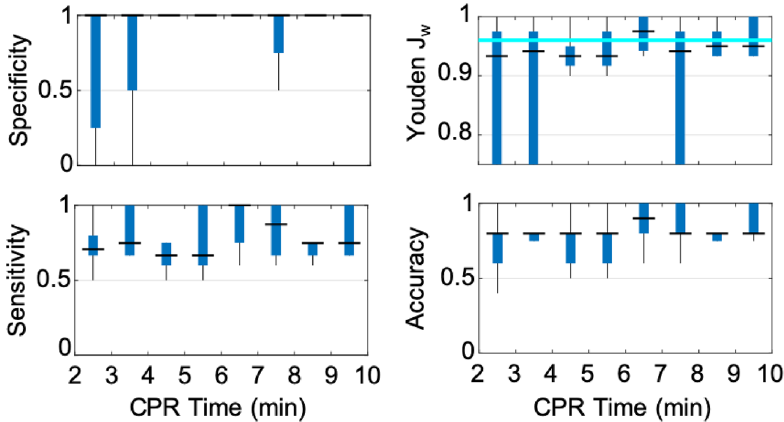
Figure 5. Time-Dependent Prediction Performance during Early CPR: The predictive performance of the optimal decision threshold (Δ[HbO 2 ] CPR ≥ + 1.3 µmol/L), across 10 independent test folds, is summarized (median, horizontal line ; interquartile range, box ; range, whisker ) minute-to-minute from 2 to 10 min of CPR. Within each 1-min interval, the decision threshold was applied to predict ROSC in each test fold and the corresponding specificity (top left), sensitivity (bottom left), accuracy (bottom right), and J w (top right) were calculated. This provides a realistic rendering of the variability and time-dependence of the predictive performance of Δ[HbO 2 ] CPR . For comparison, the parameter’s max J w derived from mean 2–10 min CPR values, is overlaid in the J w sub-panel as a horizontal cyan line. A median specificity of 1, median sensitivity > 0.5, and a median Youden J w > 0.9 is achieved at all time